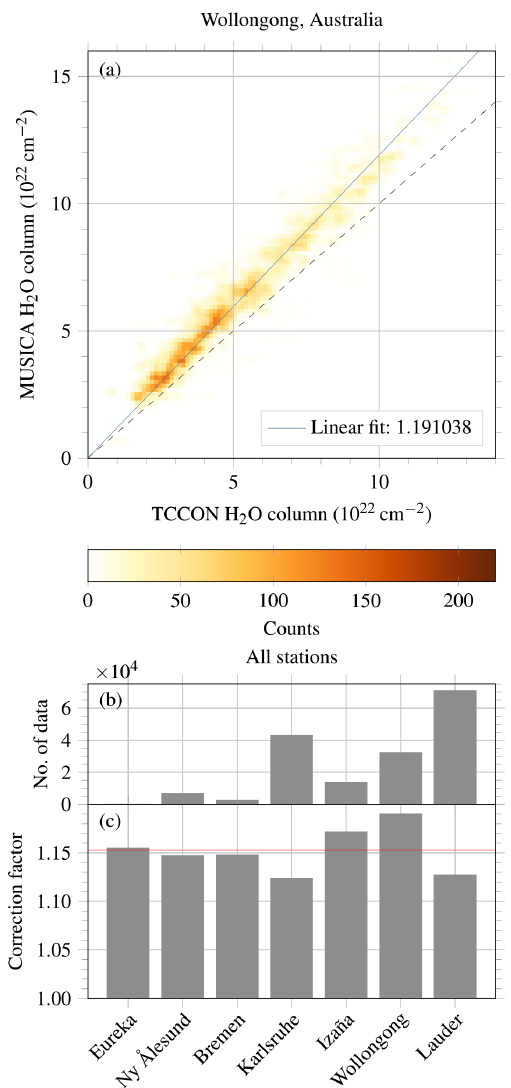
Figure 5. (a) Two-dimensional histogram of correlations of co- located TCCON and MUSICA-NDACC H 2 O columns at Wollon- gong (colour-coded) and the result of a fit of a linear correction (blue line). The one-to-one line is shown dashed. (b) Number of co-located observations for all individual stations in both networks. (c) Correction factors to correct MUSICA-NDACC H 2 O columns to TCCON. The average 1.1527 is marked by a red